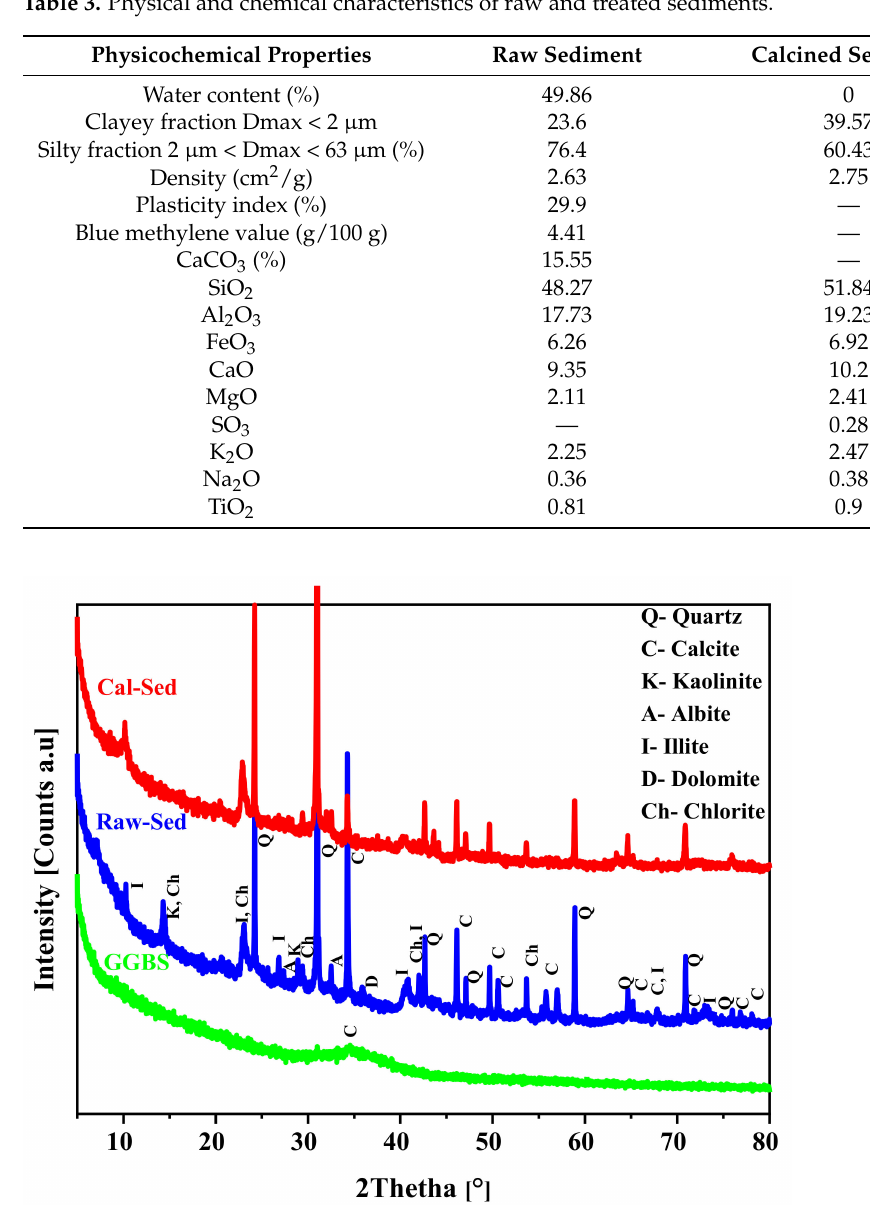
Table 3. Physical and chemical characteristics of raw and treated sediments.